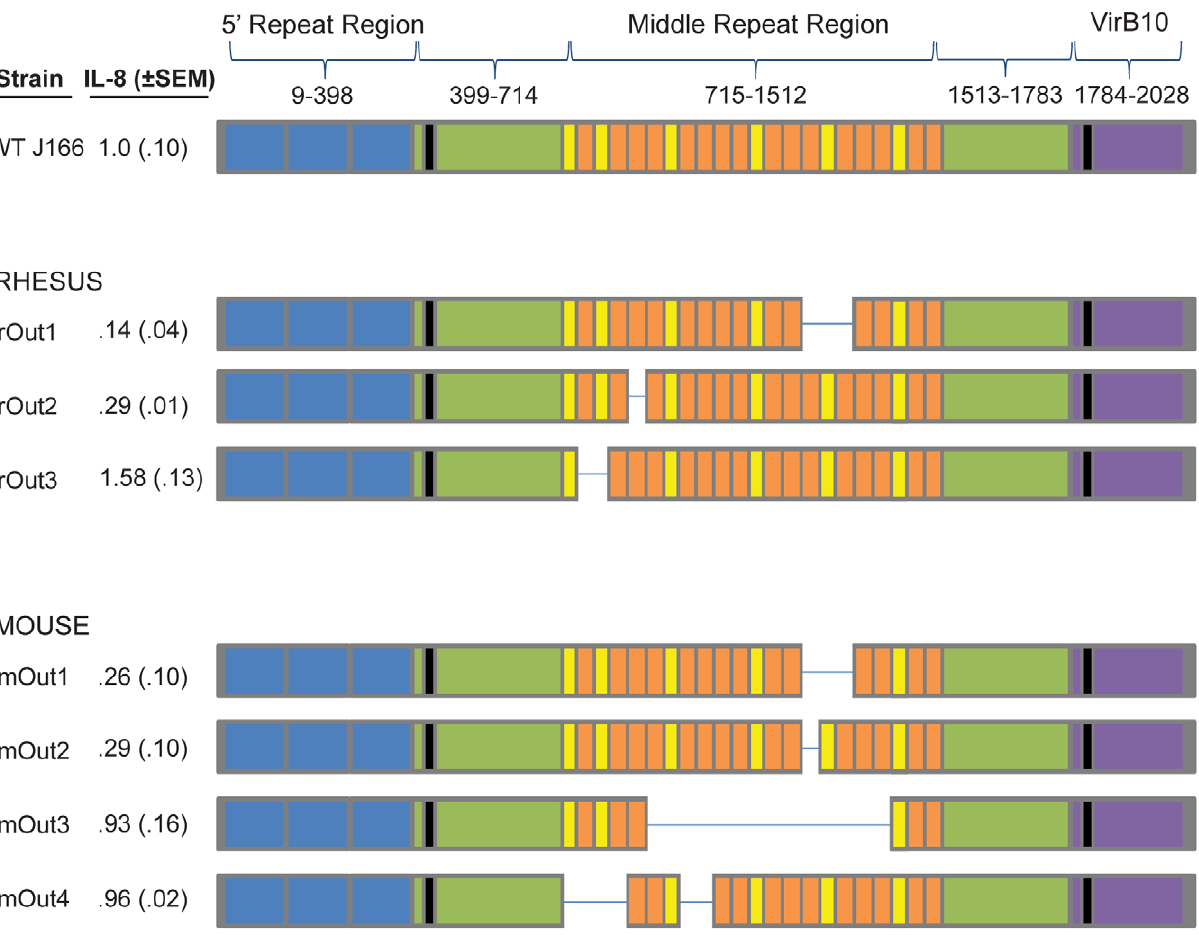
Figure 6. H.pylori colonization of rhesus monkeys and mice is associated with changes in the motif structure of the CagY middle repeat region. As in strains J99 and 26695 [19], the predicted amino acid sequence of CagY in WT H. pylori J166 is organized into a 5 9 repeat region (residues 9–398), a 3 9 region orthologous to VirB10 (residues 1784–2028), and a middle repeat region (residues 715–1512) that is composed of a series of B motifs (yellow) that bracket one to four A motifs (orange). Passage of WT J166 in rhesus monkeys and in mice results in some strains that lose one or more A or B motifs, which is sometimes sufficient to reduce the capacity to induce IL-8 (rOut1 and rOut2; mOut1 and mOut2) and other times is not (rOut3; mOut3 and